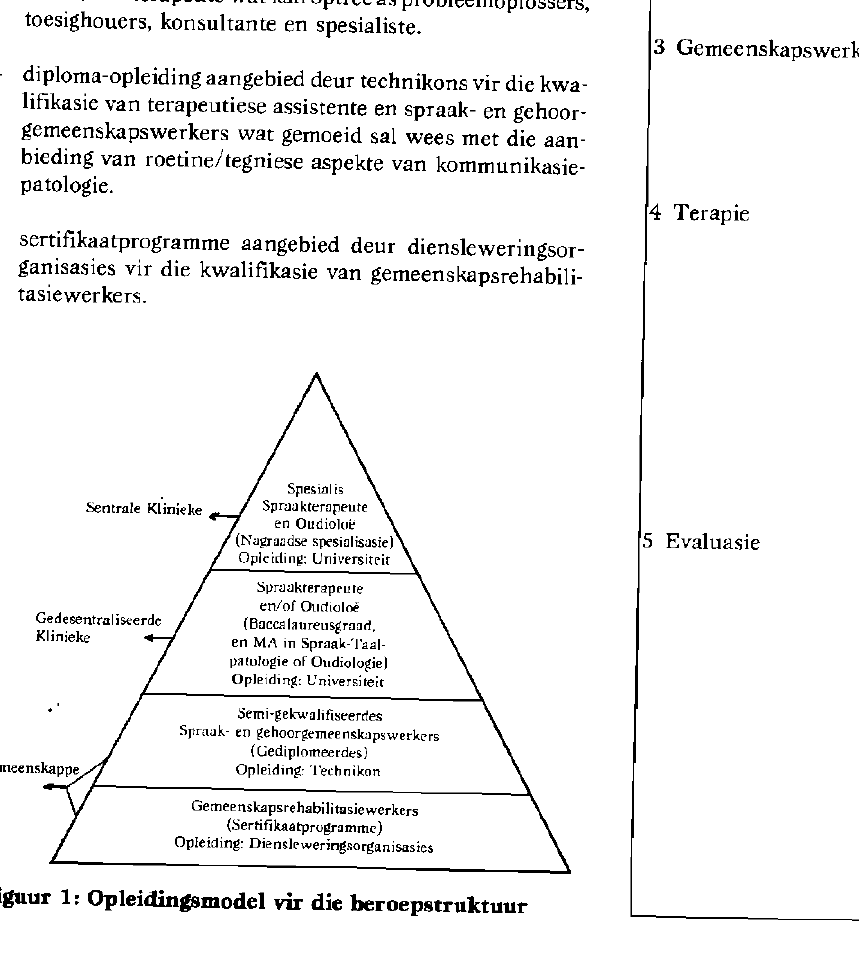
Figuur 1: Opleidingsmodel vir die